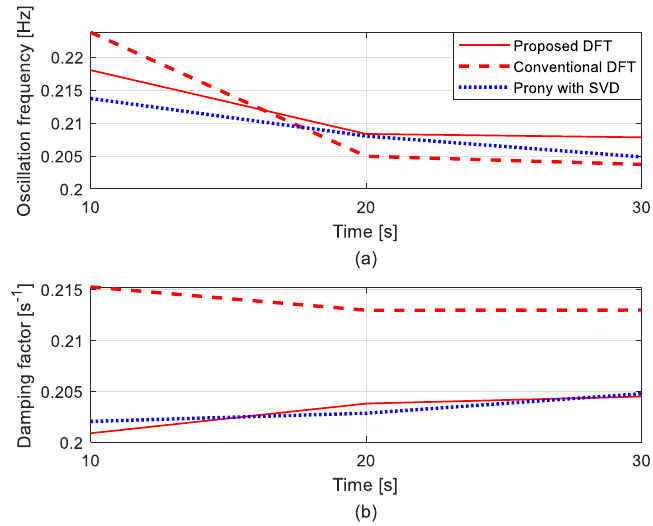
Figure 9. Estimated modal parameters of the Central American power system: ( a ) oscillation frequency of the interarea mode; ( b ) damping factor of the interarea mode.